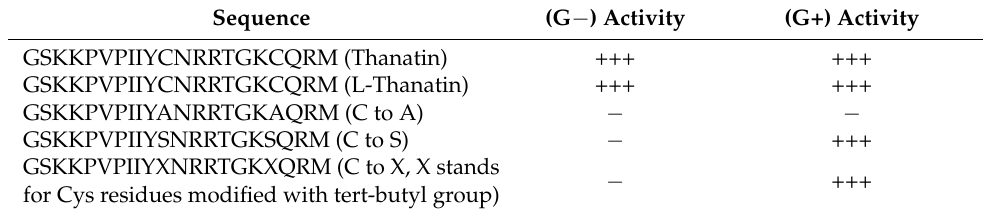
Table 4. Role of the disulfide bond in the antimicrobial activity of thanatin.